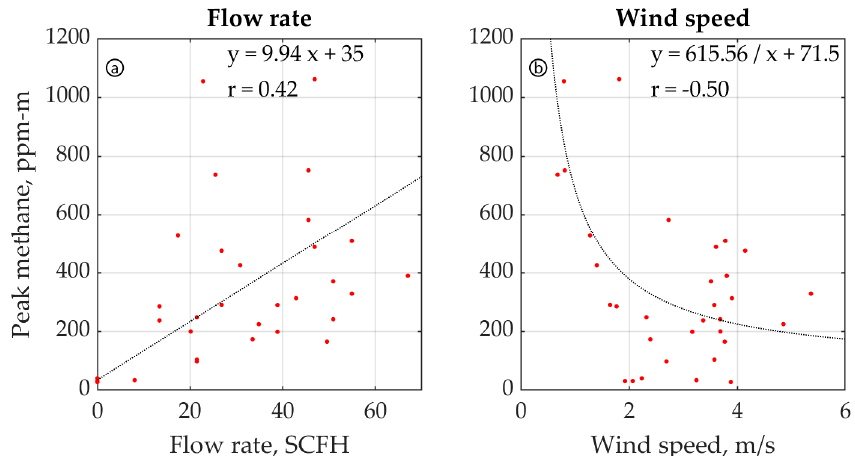
Figure 5. Components of the correlation-based quantification method: flow rate is derived from the combination of ( a ) peak methane (ppm-m) versus known flow rate (SCFH); ( b ) peak methane versus wind speed, here shown separately for illustration and with the linear regression in ( a ) forced through background. The combined relationship, with refinements described in the text, is shown in Figure 9. For ( a ), regression yielded (±2 σ ) a slope of 9.94 ± 4.78 ppm-m SCFH − 1 and intercept of 35 ± 170 ppm-m. For ( b ), the coefficients were 615.6 ± 243.9 ppm-m m s − 1 and 71.5 ± 144 ppm-m.